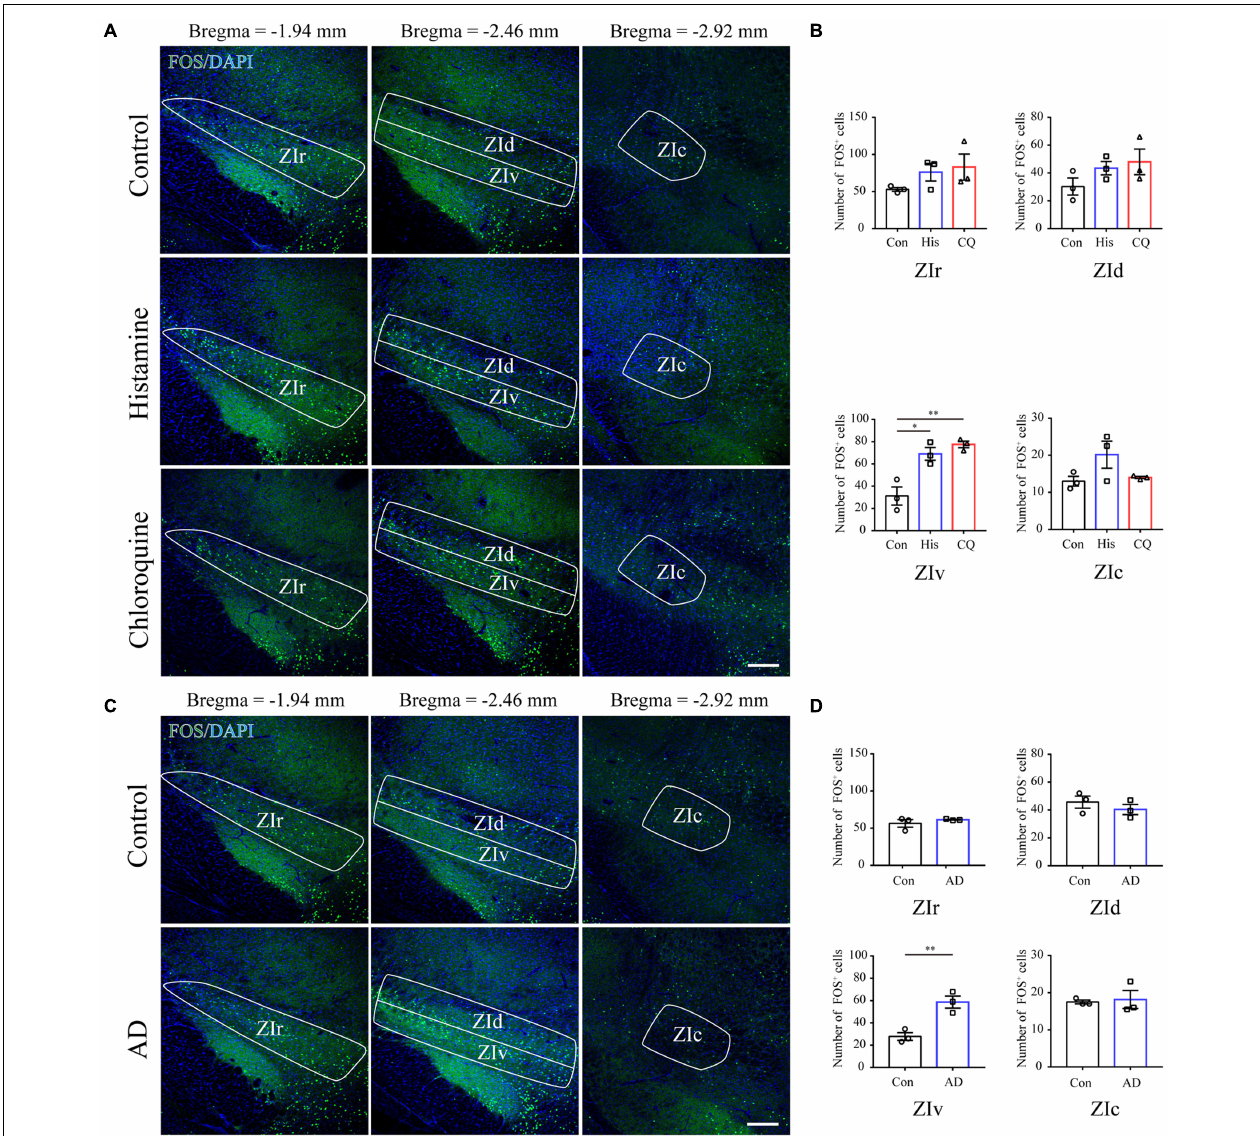
FIGURE 1 | Acute itch stimuli and Chronic itch stimuli increase FOS expression in the ZIv. (A) Representative images of FOS staining in the ZI after saline (the upper panel), histamine (the middle panel), and chloroquine (the lower panel) injection. Scale bar = 200 µ m. (B) Quantification of FOS-expressing neurons in response to saline, histamine, and chloroquine injection showed both histamine and chloroquine stimuli increased FOS expression in the ZIv instead of other ZI subregions. n = 3 mice per group, three sections per mouse. One-way ANOVA with post hoc LSD test for multiple comparisons. For the analysis in ZIv, F (2,6) = 17.378, P = 0.003. (C) Representative images of FOS staining in the ZI in control (the upper panel) and AD (the lower panel) mice. Scale bar = 200 µ m. (D) Quantification of FOS-expressing neurons in control and AD mice showed AD increased FOS expression in the ZIv instead of other ZI subregions. n = 3 mice per group, three sections per mouse. Unpaired T -test. For the analysis in ZIv, t = –4.759, P = 0.009. ZIr, the rostral ZI; ZIv, the ventral ZI; ZId, the dorsal ZI; ZIc, caudal ZI; AD, atopic dermatitis. ∗ P < 0.05, ∗∗ P <